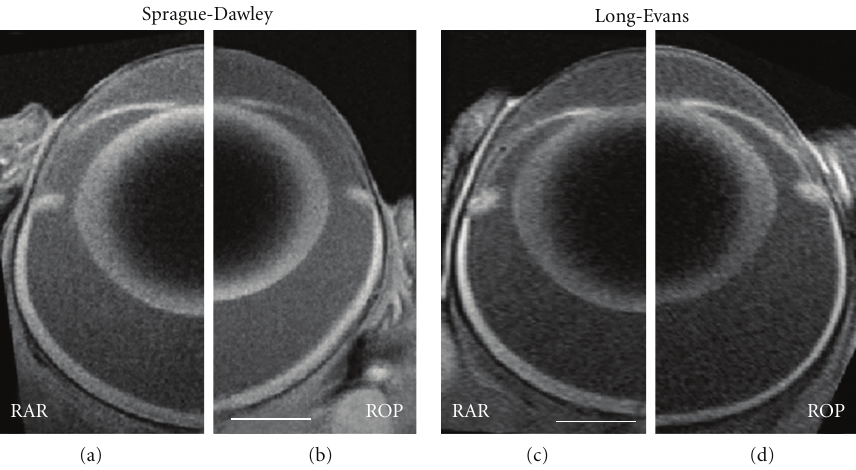
Figure 6: MR images obtained in ∼ P50 Sprague-Dawley RAR (a) and ROP (b) rats and Long-Evans RAR (c) and ROP (d) rats. All images are displayed at the same magnification (scale bars are 1mm). The ROP rat images (b, d) are mirrored to eliminate nasal-temporal asymmetries, if any. Note that the ROP rat eyes are characterized by steeper corneae and relatively reduced anterior segment depths. Note also that the Sprague-Dawley ROP rat has a short axial